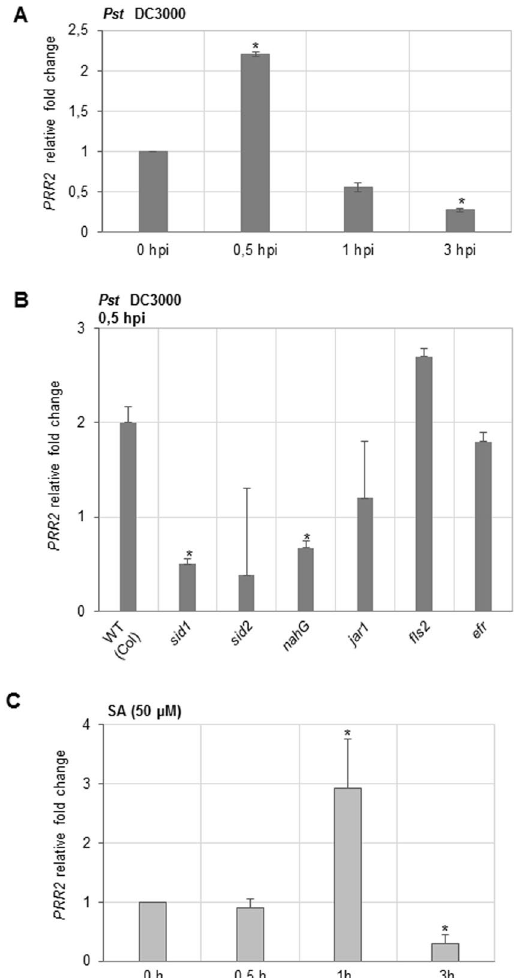
Figure 2. PRR2 gene expression analyses in response to Pseudomonas syringae inoculation and to salicylic acid treatment. ( A ) PRR2 gene expression in response to P . syringae infection. Leaves of 4-week-old Col plants were inoculated with Pst DC3000 at 5.10 7 cfu.mL − 1 . Samples were collected at 0, 0.5, 1 and 3 h post-inoculation (hpi). ( B ) PRR2 gene expression in mutants defective for hormonal production and MAMP perception. PRR2 expression was monitored 0.5 h after Pst DC3000 inoculation in 4-week-old Arabidopsis mutants defective for SA production ( sid1 , sid2 and a line carrying the nahG transgene), JA ( jar1 ) signalling pathways but also in mutants altered in flagellin ( fls2 ) or EF-Tu ( efr ) perception. ( C ) Time-course of PRR2 gene expression in response to exogenous application of salicylic acid (SA 50 µ M). Seedlings were collected at 0, 0.5, 1 and 3 h after SA treatment. All the expression analyses are presented as a fold change relative to mock treatment. Relative transcript quantification was assayed by quantitative real-time PCR and calculated by the comparative 2 −ΔΔ CT method using actin8 as a reference gene. Data illustrated represent the mean ± SE of three biological replicates from two independent experiments. Asterisks ( * ) above histograms (ANOVA, p-value 0.05) indicate significant changes of PRR2 gene expression in these different genetic backgrounds compared to WT